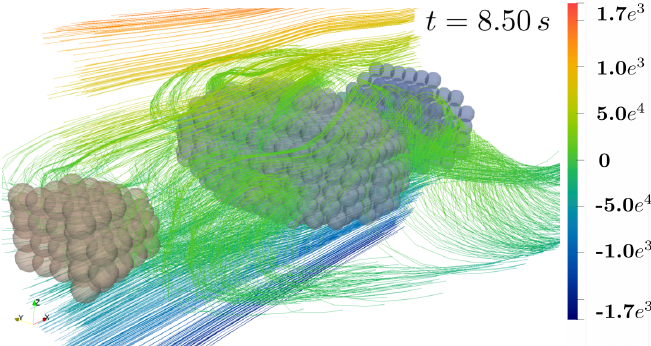
Figure 14. 3-dimensional view of streamlines at timestep t =